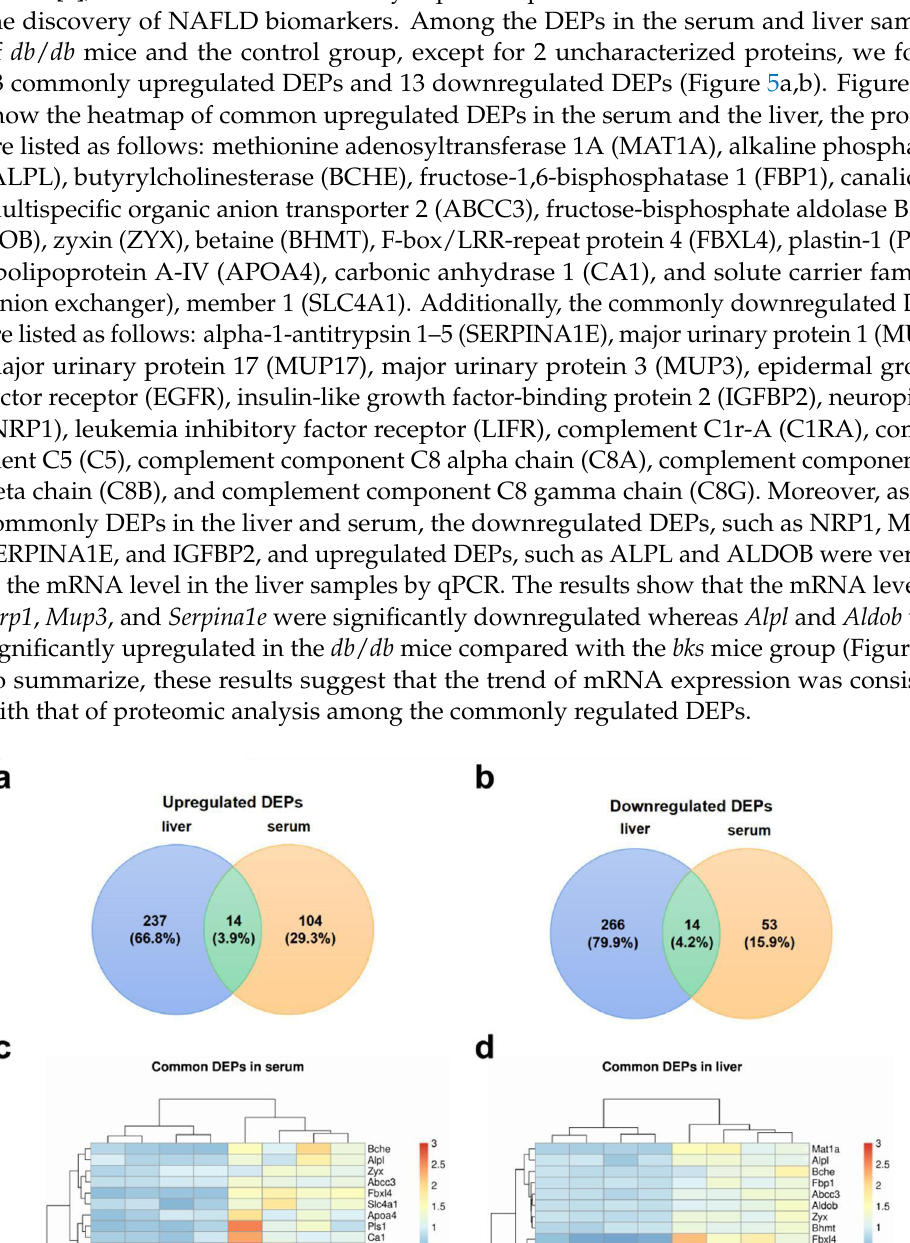
Figure 5. The confirmation of common DEPs in the sera and livers of db / db mice. ( a ) Commonly up- regulated DEPs in the sera and livers of db / db mice and bks mice ( n = 5). ( b ) Commonly downregu- lated DEPs in the sera and livers of db / db mice and bks mice ( n = 5). ( c ) Heatmap of the commonly upregulated DEPs. ( d ) Heatmap of the commonly downregulated DEPs. ( e ) The validations of some of the common DEPs. Red dots represent bks mice and blue squares represent db/db mice. * p < 0.05; ** p < 0.01; *** p < 0.001. 3. Discussion Linked to obesity, type 2 diabetes, and other metabolic dysregulation, the continu- ously increased incidence of NAFLD has become a worldwide public health problem [20]. Sustainable efforts should discover candidate biomarkers for NAFLD diagnosis and prog- nosis. Recently, TMT-labeled proteomic analysis has been considered a valuable tool for the diagnosis and prognosis of diseases. As a classic genetically obese mice model, db / db mice presented obesity and NAFLD, making the db / db mouse the optimal animal model for NAFLD. Of note, instead of the costly and not widely acceptable liver biopsy, there is an urgent need to discover non-invasive serum biomarkers for NAFLD and the